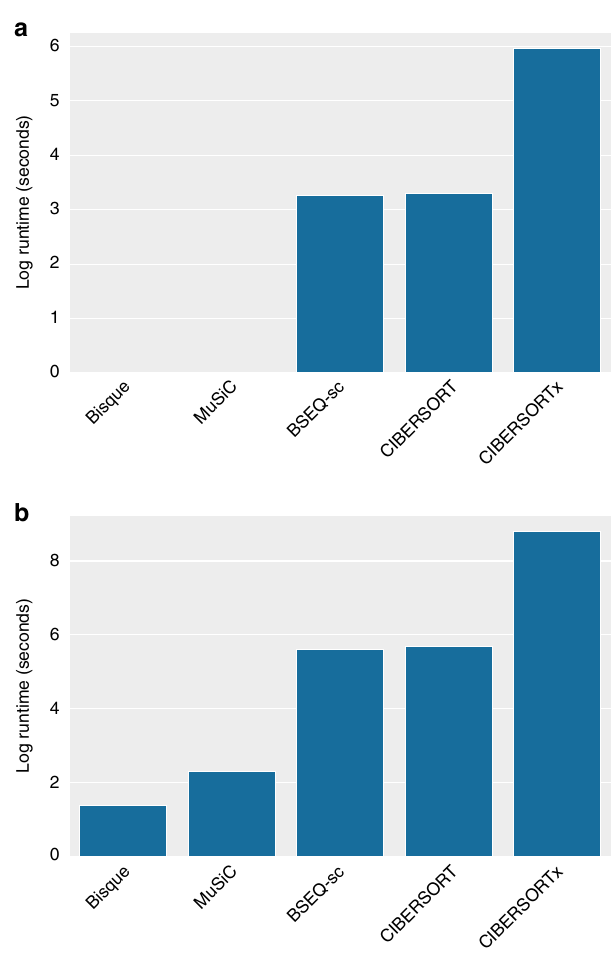
Fig. 5 Runtime comparisons in log-transformed seconds for benchmarked reference-based decomposition methods. a Runtime for subcutaneous adipose dataset, which included 100 RNA-seq samples and 6 snRNA-seq samples with around 1800 nuclei per individual. b Runtime for dorsolateral prefrontal cortex dataset, which included 628 RNA-seq samples and 8 snRNA-seq samples. We benchmarked each method using around 2125 nuclei per snRNA-seq sample. Source data are provided as a Source Data fi